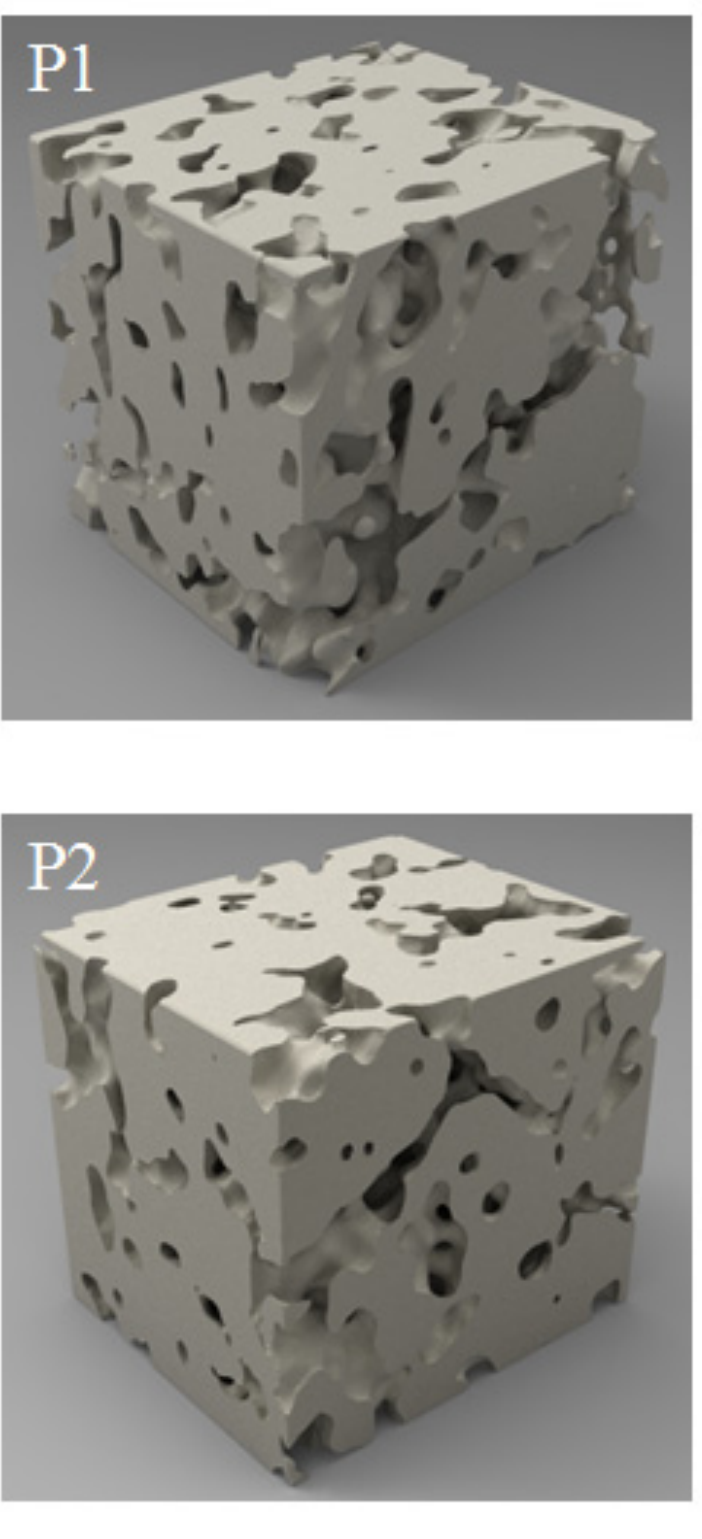
Figure 7. P1 and P2 sample reconstruction based on computer microtomography. The visible 1.4 × 1.3 × 1.2 mm region comes from the inside of samples.